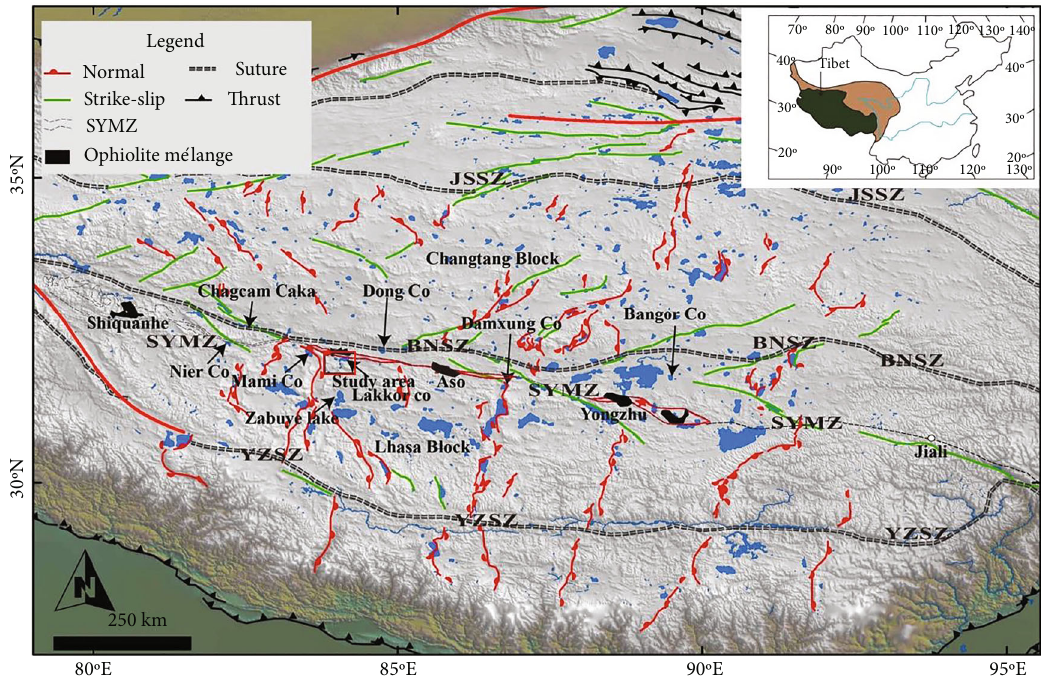
Figure 1: Map showing the location and tectonic setting of the study area (modi fi ed from Lü et al.